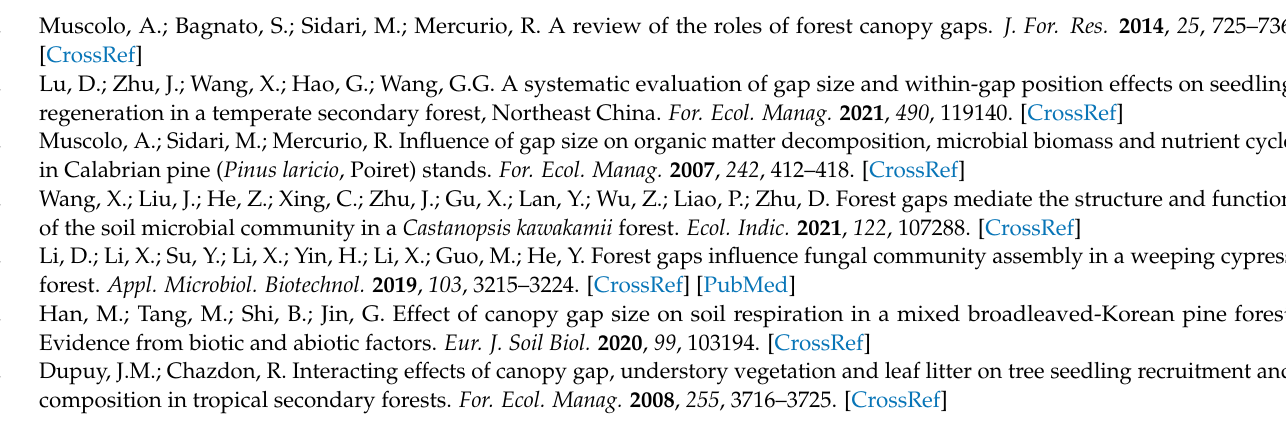
Table S1: Analysis of similarities (ANOSIM) and permutational multivariate analysis of variance (PERMANOVA) based on weighted UniFrac distance at different gap size levels; Table S2: Topological characteristics of co-occurrence networks of soil bacteria community in forest gaps and closed forests; Table S3: Percent variance explained of the composition of soil bacterial community by each gap- related microenvironmental factor; Table S4: Percent variance explained of the diversity and network structure of soil bacterial community by each gap-related microenvironmental factor; Table S5: The SEM’s fitting parameters of forest gaps and closed forests for L. principis-rupprechtii Mayr plantations after